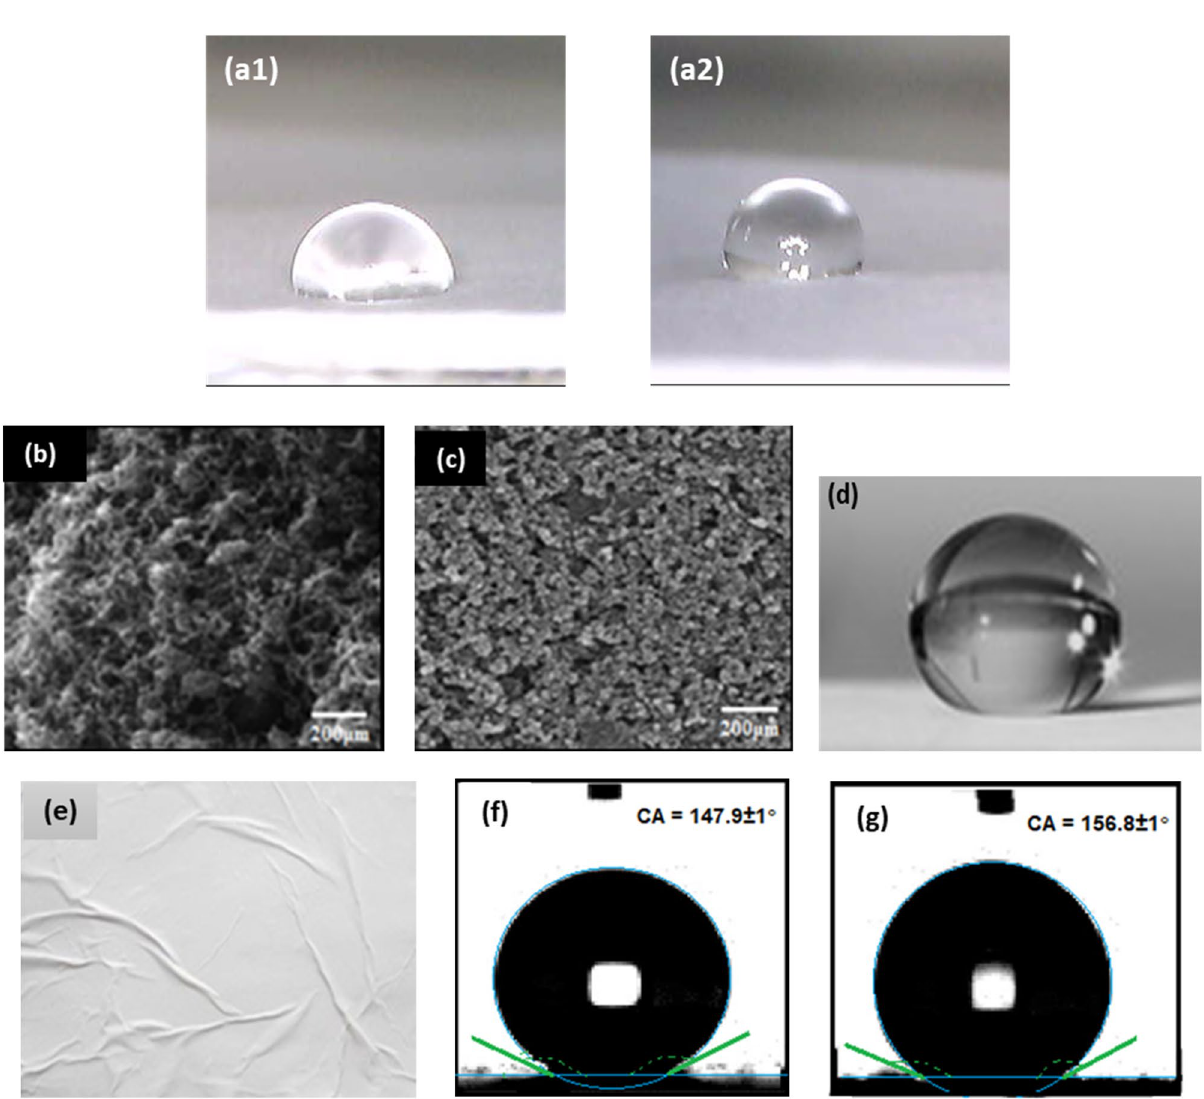
Figure 6. Water droplets on ( a1 ) low quality and ( a2 ) high-quality print areas after first print of Ti1; SEM images of paper spray coated with ( b ) Ti1 ink solution, ( c ) Ti2 ink solution (EVO 50 (CARL Zeiss) system); ( d ) Perfectly spherical water droplet on 7 times Ti1 printed paper; ( e ) Coated paper getting wrinkled and crumpling after the 7th cycle; Static contact angle on paper printed 5 times using ( f ) Ti1, ( g ) Ti2 (Contact angle goniometer (DATA Physics OCA 15